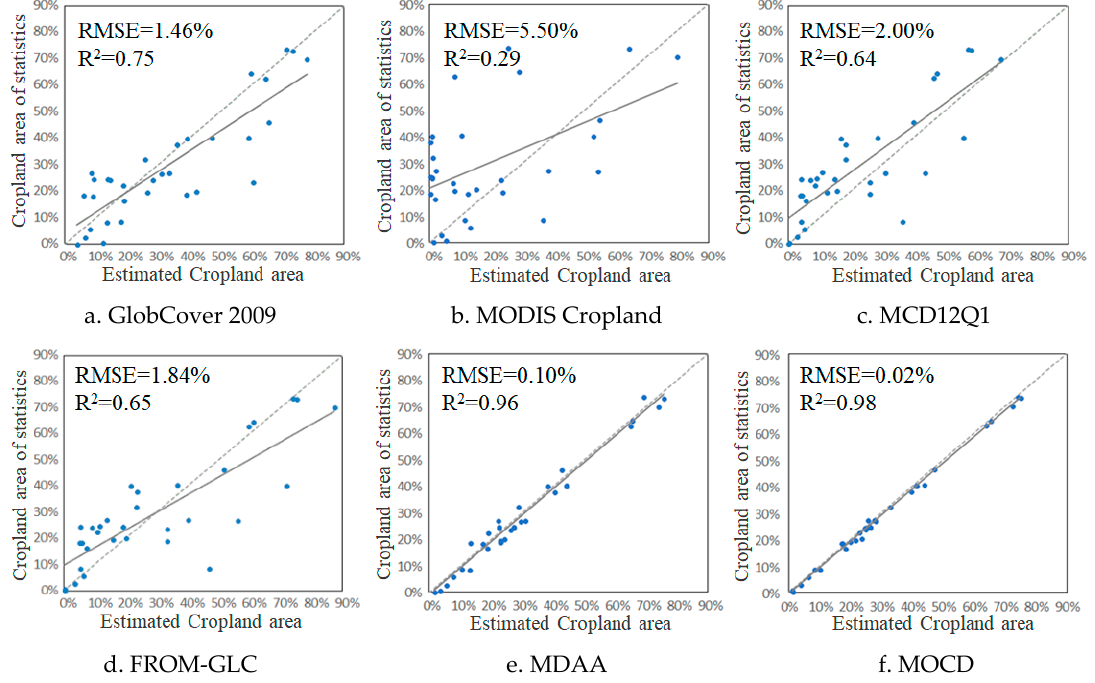
Figure 7. Scatterplots of the cropland area from statistics and those estimated by ( a ) GlobCover 2009; ( b ) MODIS Cropland; ( c ) MCD12Q1; ( d ) FROM-GLC; ( e ) the synergy cropland product generated by MDAA; and ( f ) the synergy cropland product generated by MOCD.